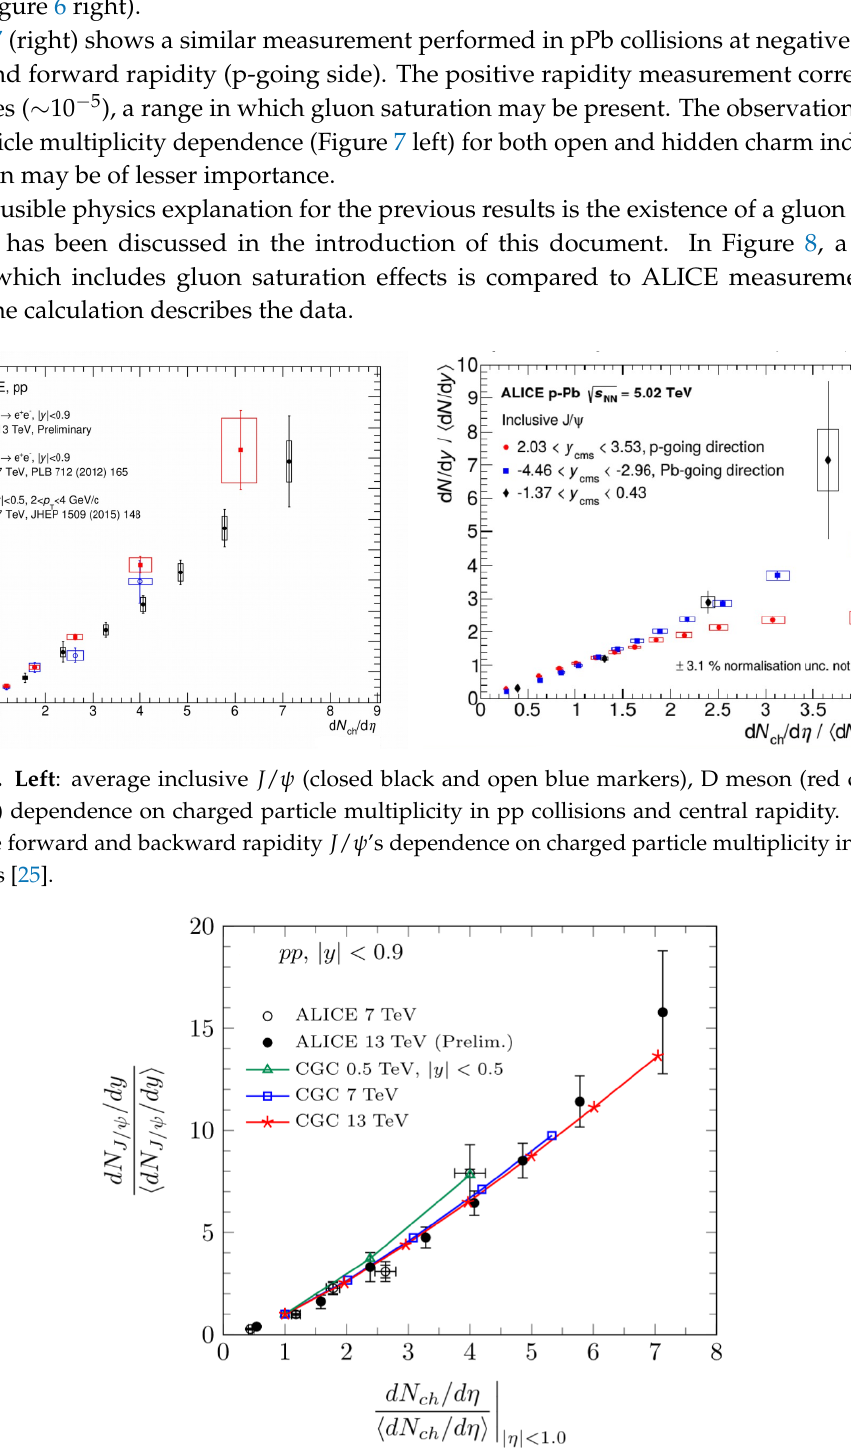
Figure 8. CGC comparisons [15] to recent J / ψ multiplicity results in pp